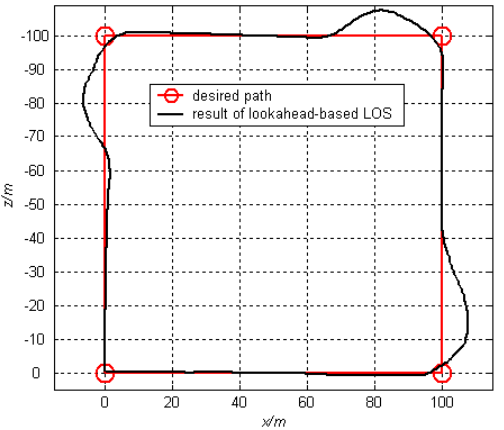
Figure 31. Path following experiment with lookahead-based LOS.